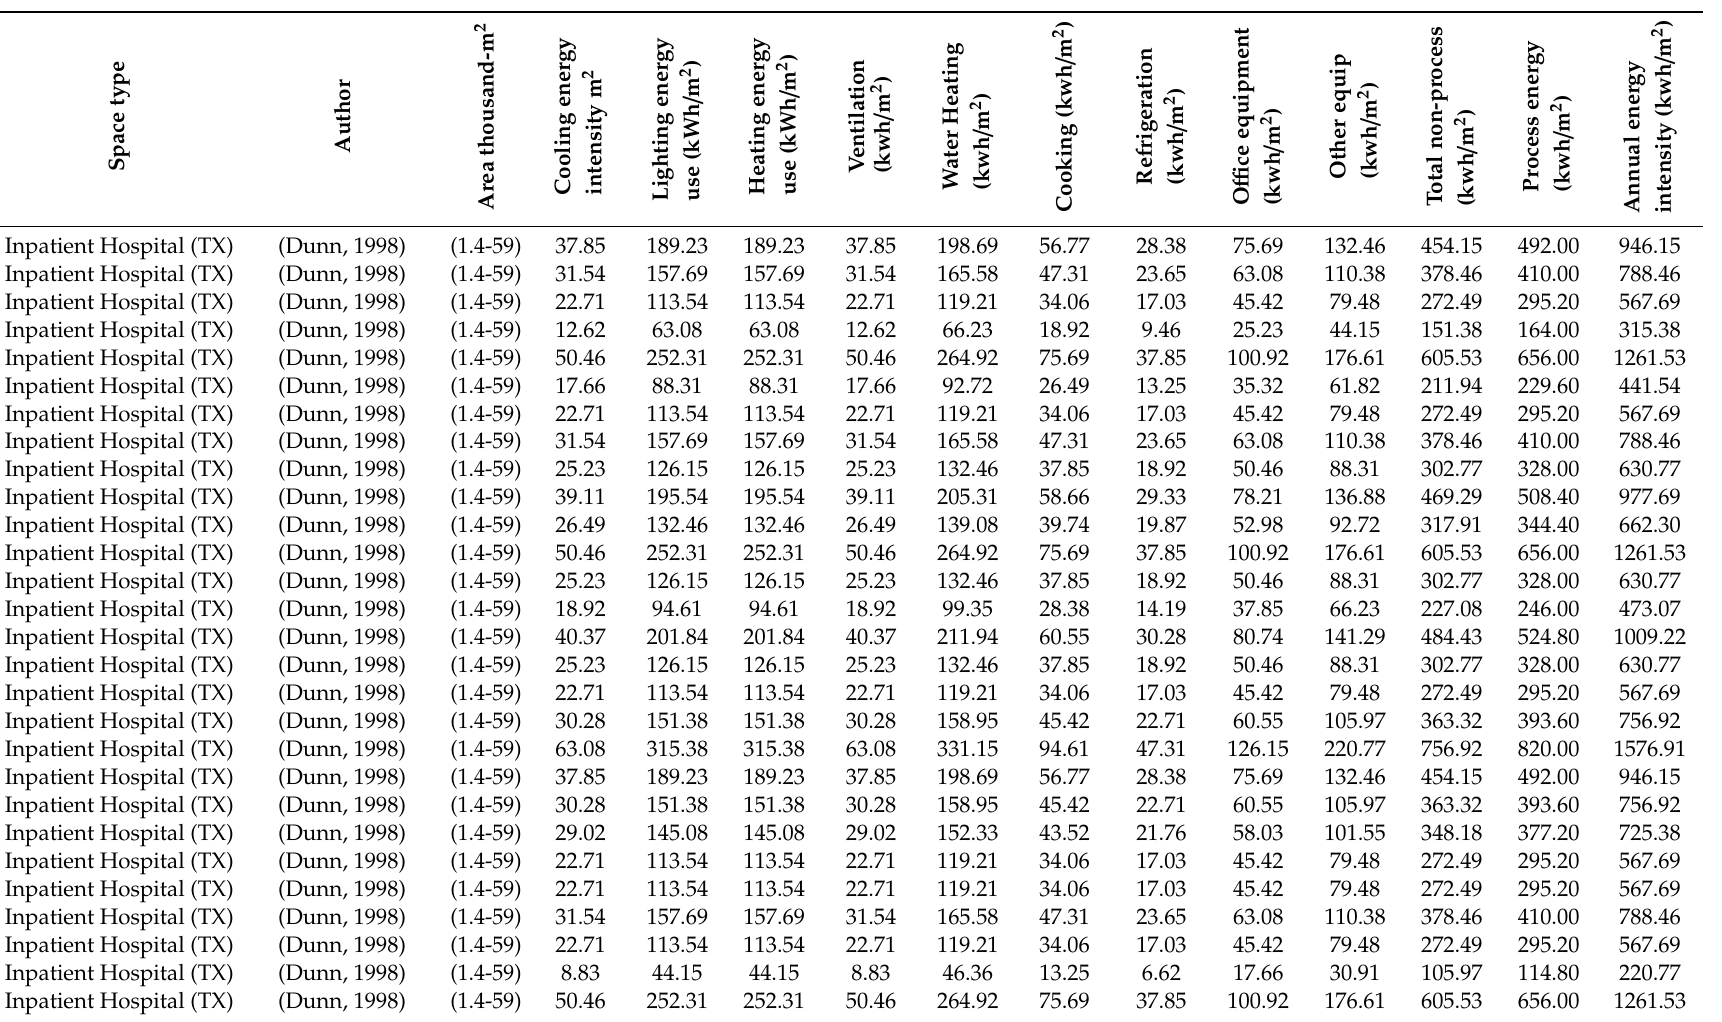
Table A2. Annual energy intensity for healthcare